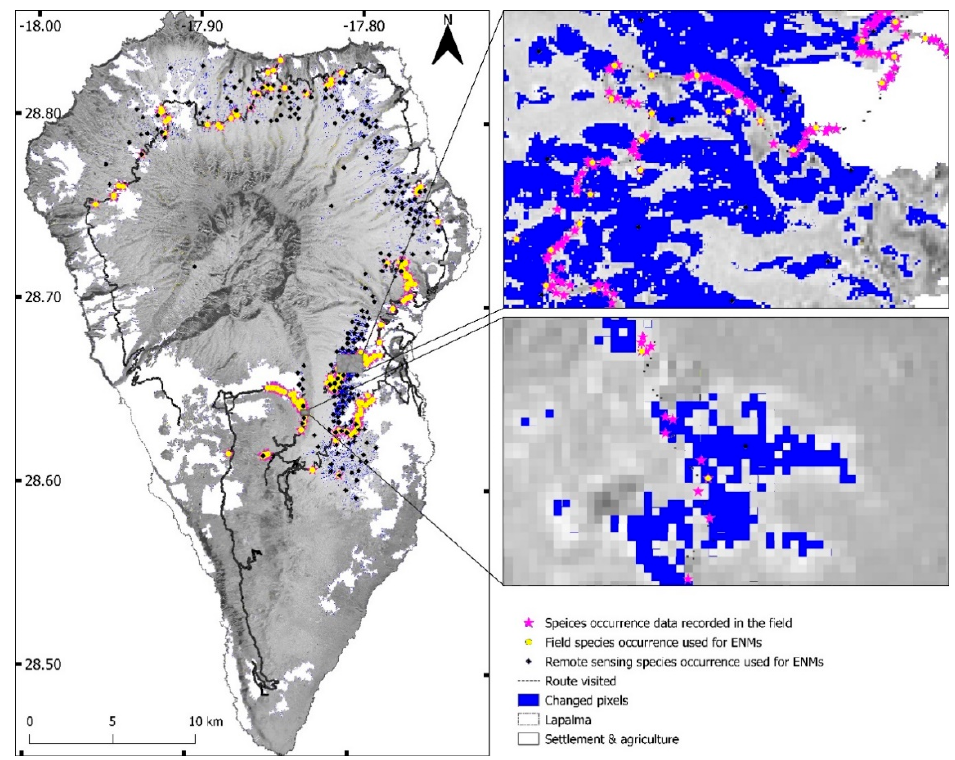
Figure A1 . Species occurrence locations recorded from field and species occurrence locations used in Ecological niche modellings (ENMs) with two cut-out sections for details.